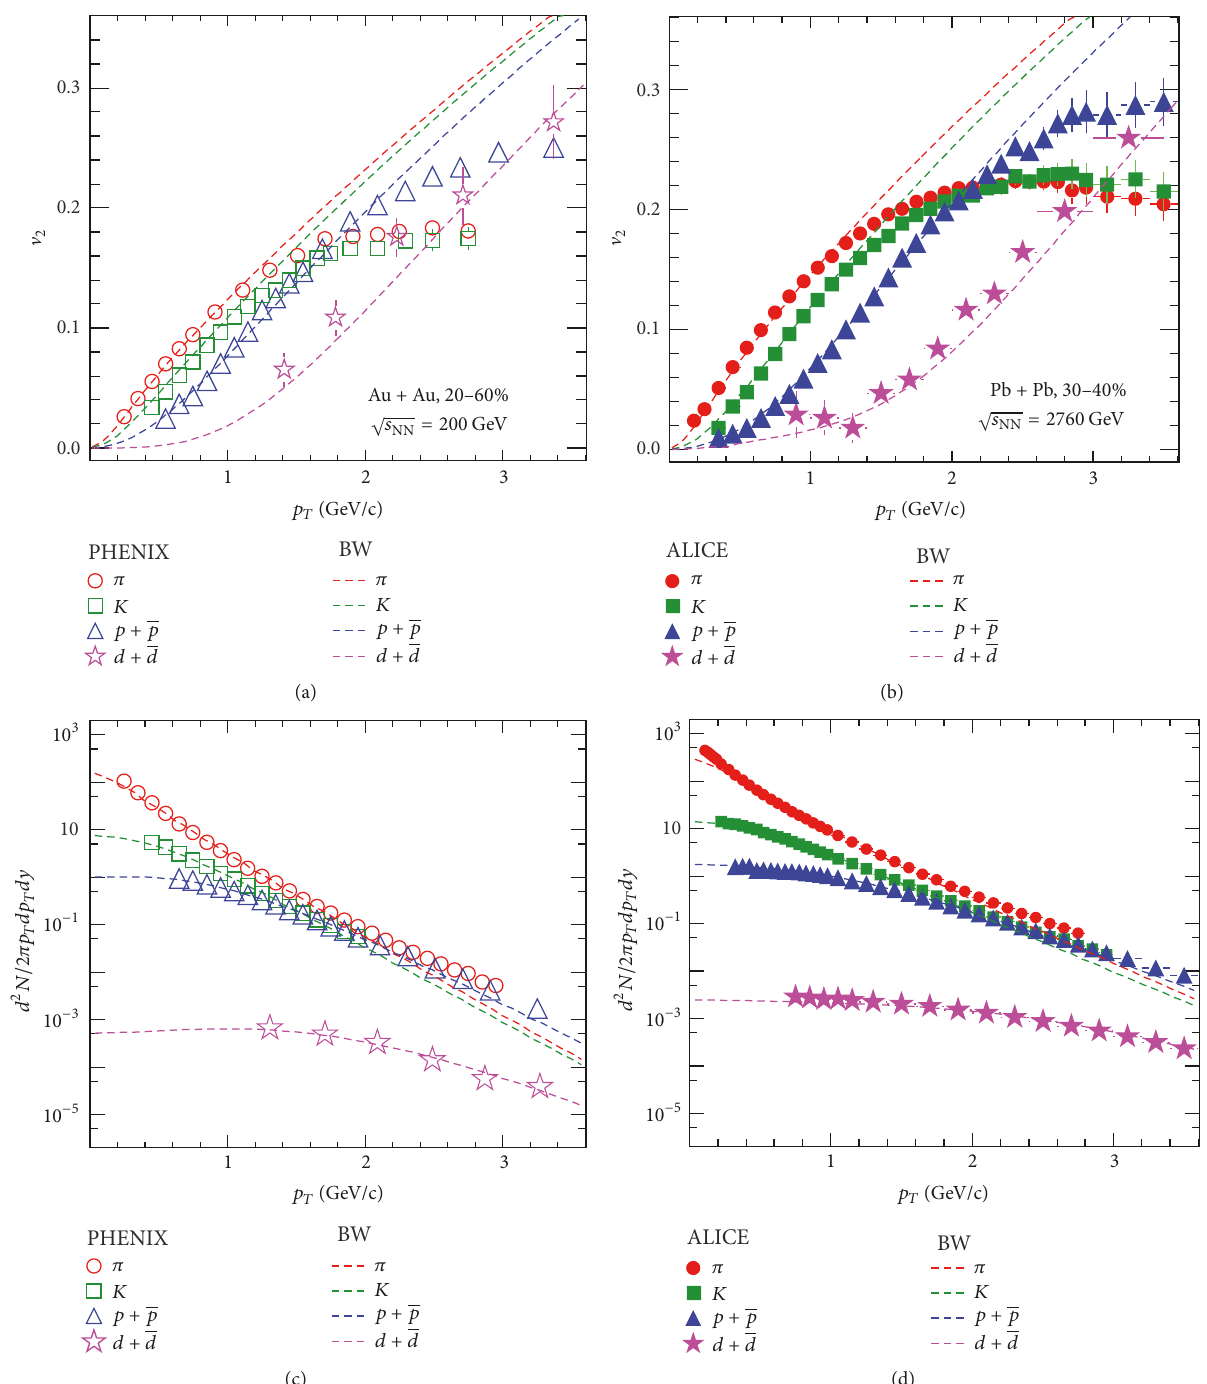
Figure 9: (a) Blast-wave fit of 𝜋 , 𝐾 , 𝑝(𝑝) , 𝑑(𝑑) V 2 , and (c) 𝑝 𝑇 spectra from the PHENIX experiment. The same is shown for the ALICE experiment in panels (b) and (d). 𝑝 𝑇 spectra are used from [45, 101]. Marker for PHENIX data corresponds to 20–60% and marker for ALICE data corresponds to 30–40% central